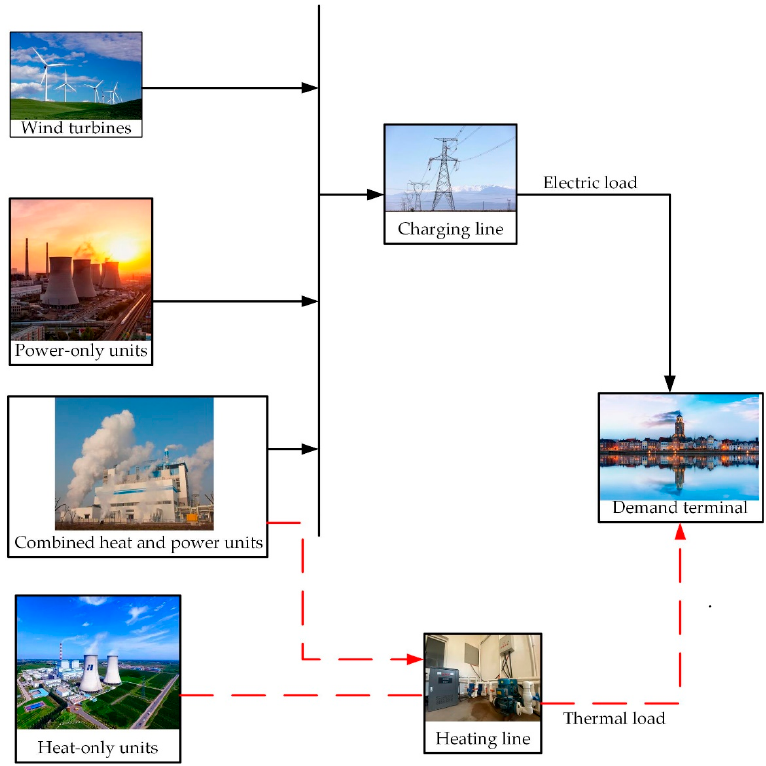
Figure 7. Energy dispatch system based on the unpredictability of load and wind power.